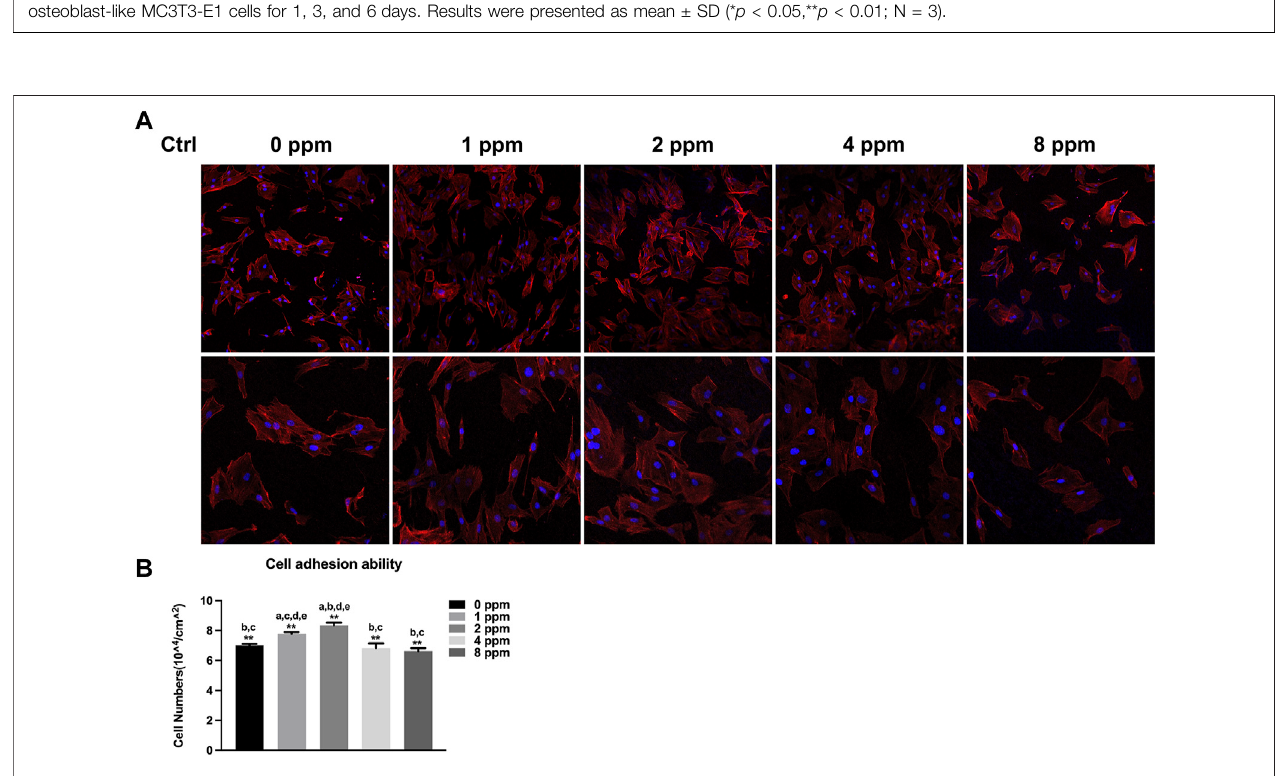
FIGURE 6 | Cell adhesion ability assay. The adhesion ability of MC3T3-E1 cells was analyzed by counting the stained nuclei with DAPI using a confocal laser scanning microscope (CLSM) after incubation. (A) CLSM images of the cells under different zinc ions concentrations at ×100 and ×200 magni fi cation. (B) Statistical results for adhesive cell numbers (* p < 0.05,** p < 0.01; N =